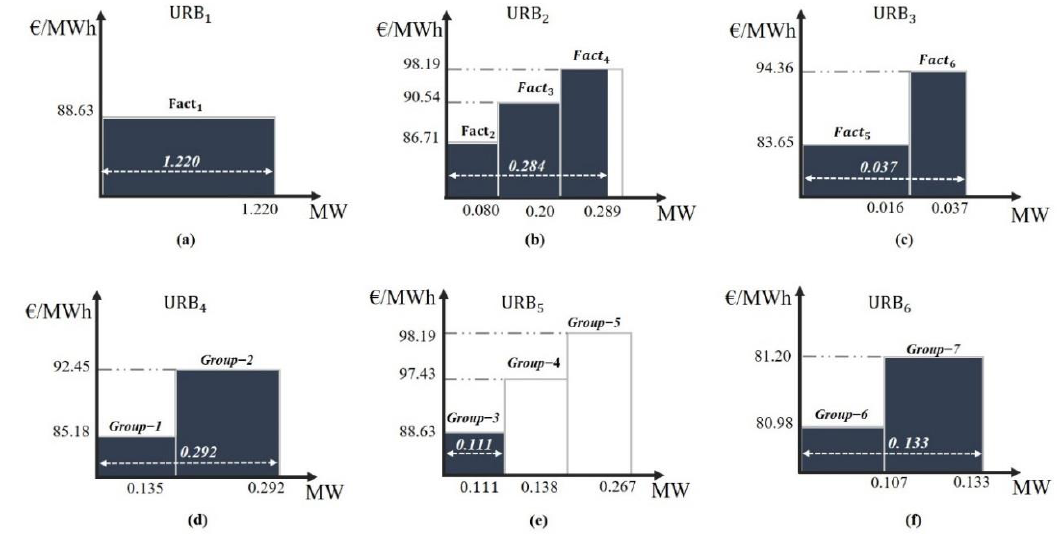
Figure 9. Activated blocks from the industrial ( a – c ) and residential aggregated bids ( d – f ) at hour 19. Table 10. Flex-DLM results for day-ahead operation.